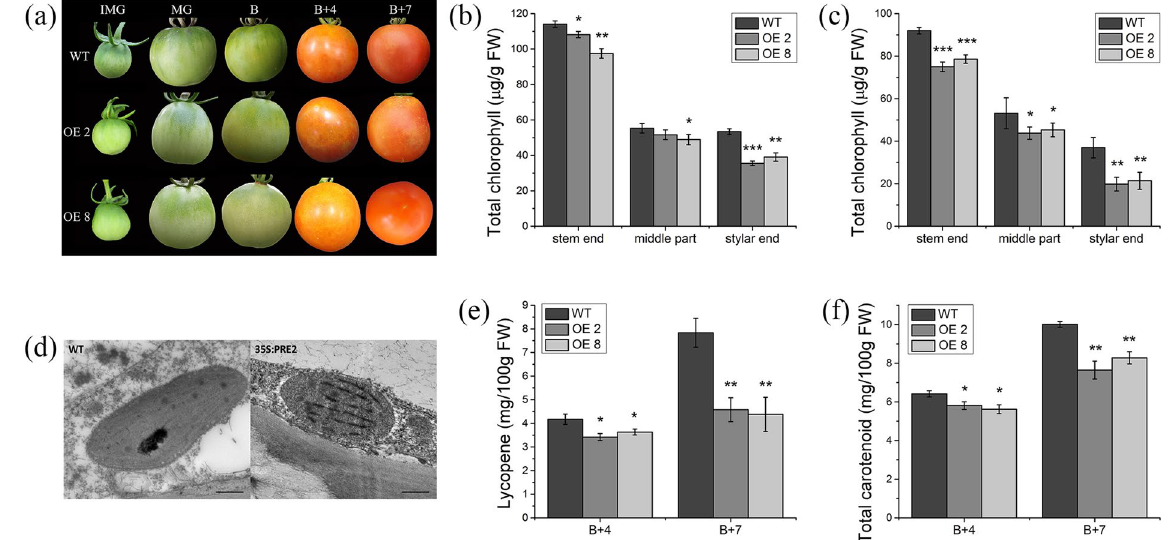
Figure 6. Phenotype and physiology in transgenic tomato fruits. ( a ) Fruits phenotype of wild type (top) and 35 S:PRE2 lines at IMG, MG, B, B + 4 and B + 7 stages (middle and bottom). ( b ) and ( c ) Chlorophyll contents of three latitudinal sections from wild type and 35 S:PRE2 fruits in MG and B stage. ( d ) Transmission electron microscopy images of MG fruit outer pericarp chloroplasts from wild type and 35 S:PRE2 lines. Bars = 0.5 μ m. ( e ) and ( f ) Lycopene and total carotenoid content of fruit flesh in B + 4 and B + 7 stages. MG, mature fruit; B, breaker fruit; B + 4, 4 days after breaker stage; B + 7, 7 days after breaker stage. FW, fresh weight. Data are the mean ± SD of three biological replicates. * Significantly different from the wild type, P value t test < 0.05; ** for P < 0.01.